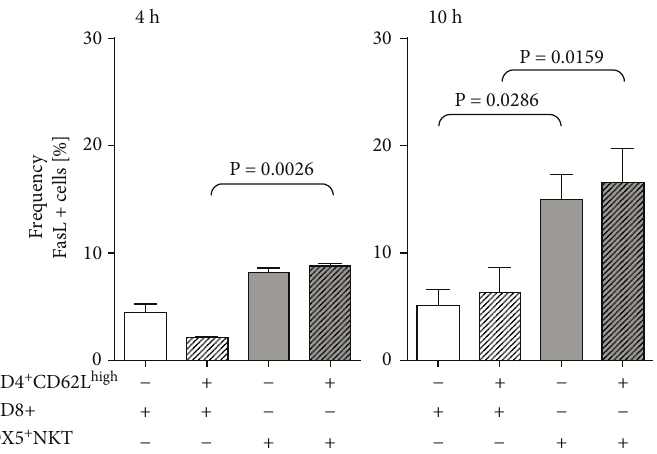
Figure 4: Flow cytometry analysis FasL expression of CD8 T and CD3 + DX5 + NKT cells after 4 h and 10h monoculture or coculture with CD4 + CD62L high cells. Results are given as mean +SEM. Experiments were repeated at least three times ( ∗ P < 0 05 ).